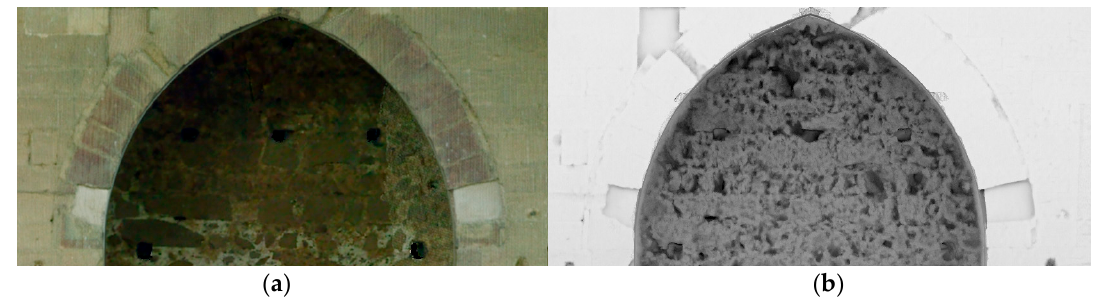
Figure 10. Efflorescence in the stone: ( a ) the RBG image showing a smooth surface; and ( b ) deterioration of the stone by alveolization of the materials shown by ambient occlusion.